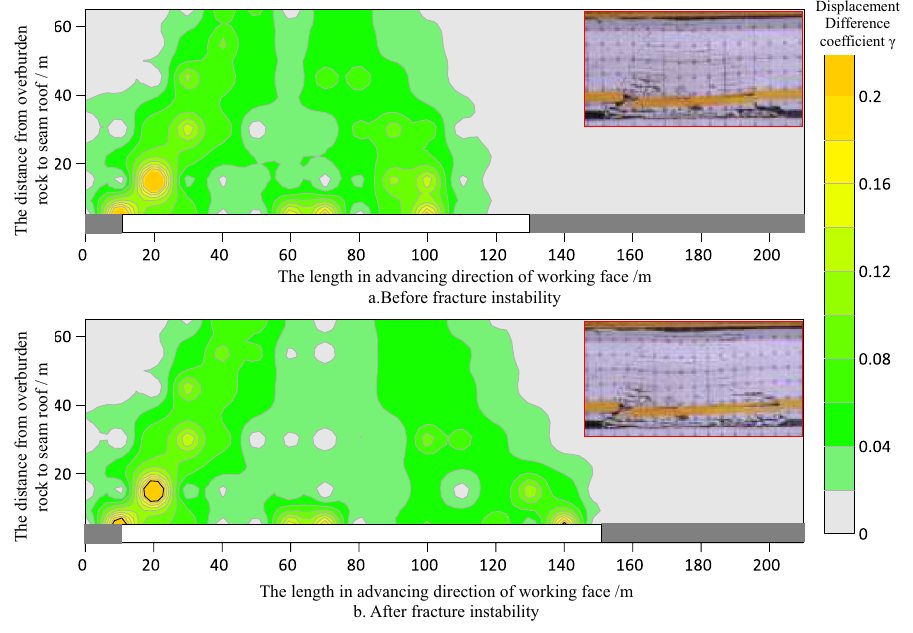
Figure 8. Contours of displacement difference coefficient γ before and after key bearing layer movement in shallow thick seam mining (key bearing layer in caving zone).